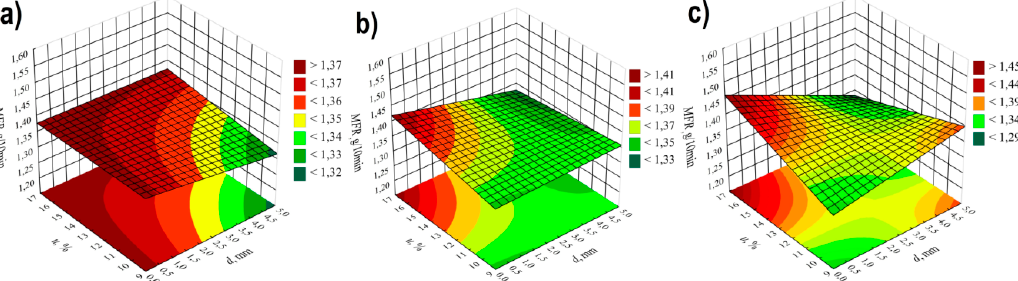
Figure 6. MFR response surface plots based on talc content u and distances between the kneading elements d , at the value of the angle between the kneading elements α of: ( a ) α = 0°;( b ) α = 30°;( c ) α = 60°.